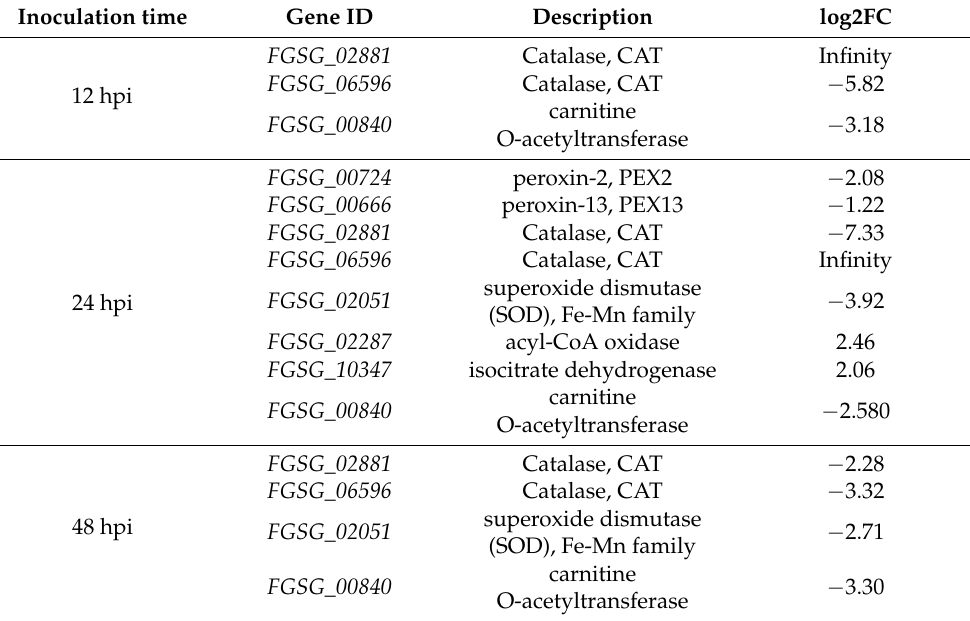
Table 2. Function and expression of genes of F. graminearum annotated in the peroxisomes pathway when infected on soybean